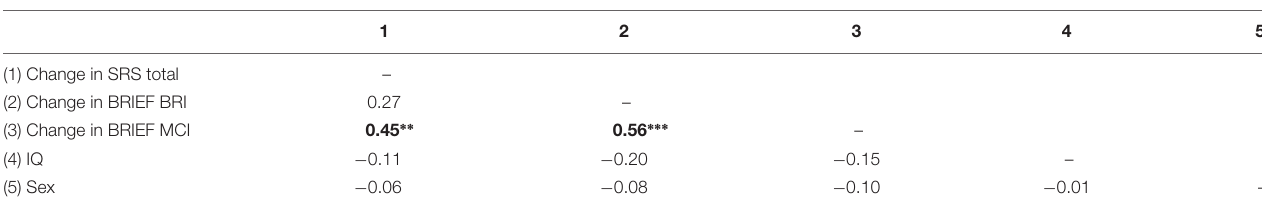
TABLE 4 | Correlation matrix of change of EF and social functioning from T 1 to T 2 in ASD. 1